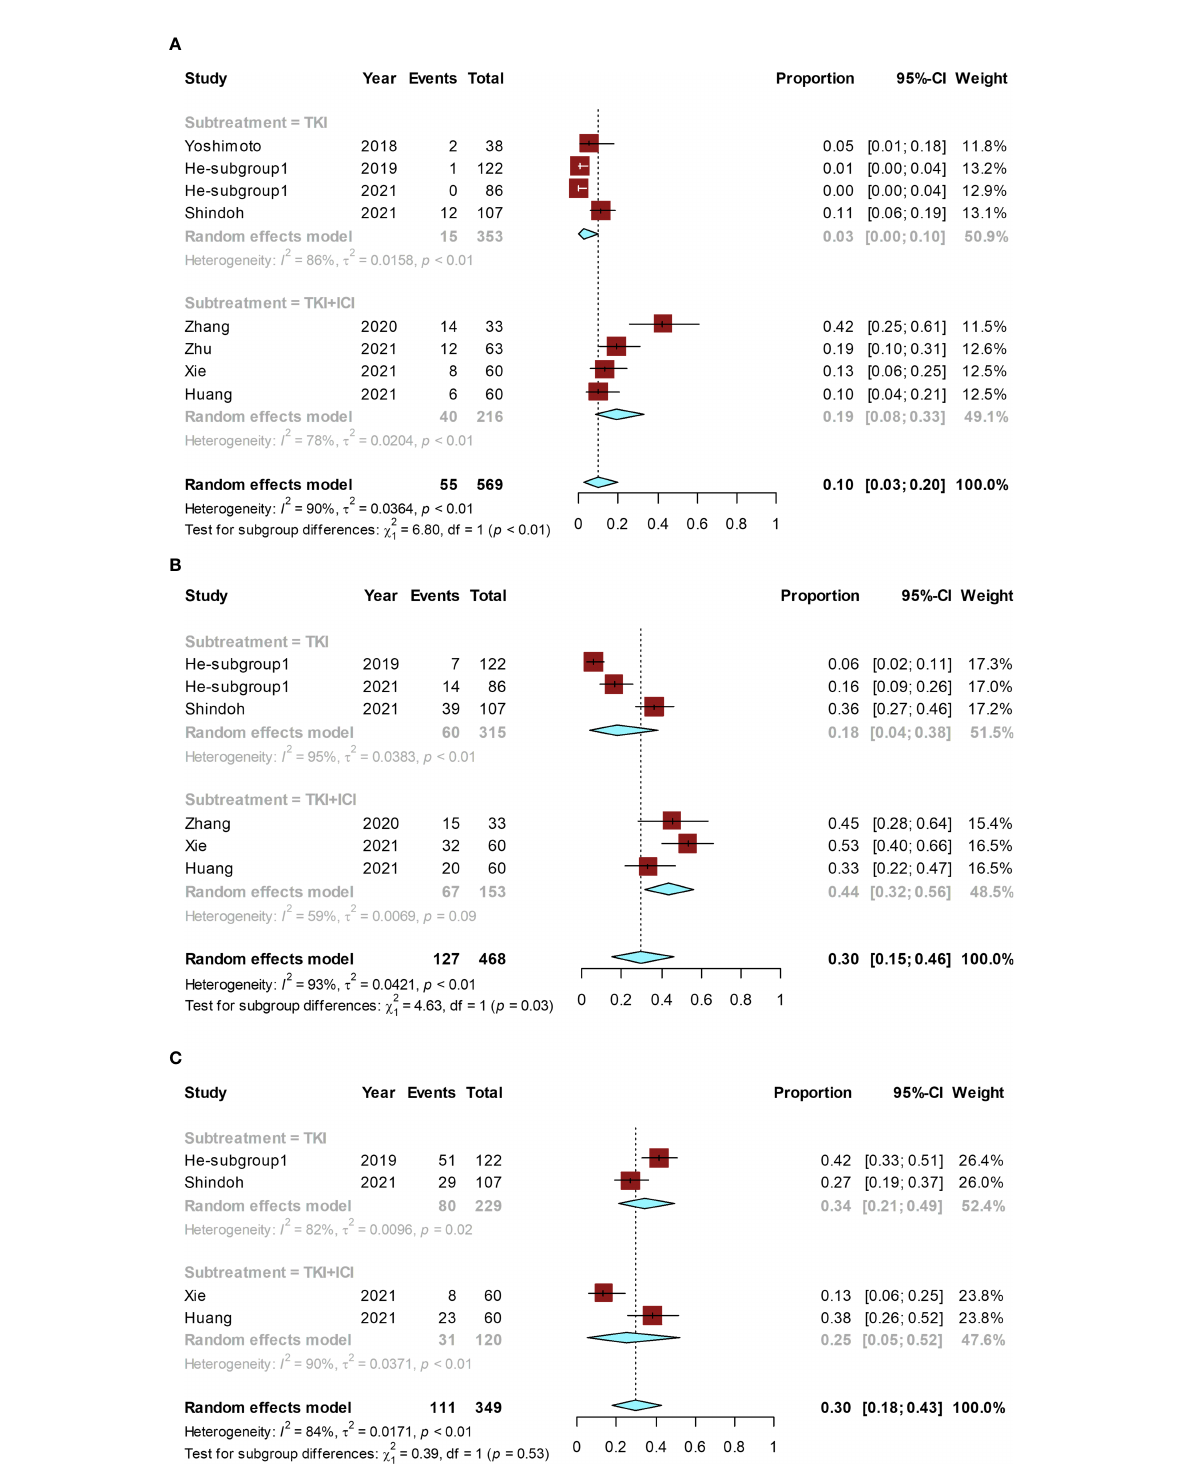
FIGURE 4 Forest plot for the molecular therapy group. Pooled rates and the subgroup analysis of conversion rate according to the use of TKI alone or TKI combined with ICI: pooled conversion rate (A) , pooled ORR (B) , and the pooled rate of grade ≥ 3 AEs (C) . TKI, tyrosine kinase inhibitor; ICI, immune checkpoint